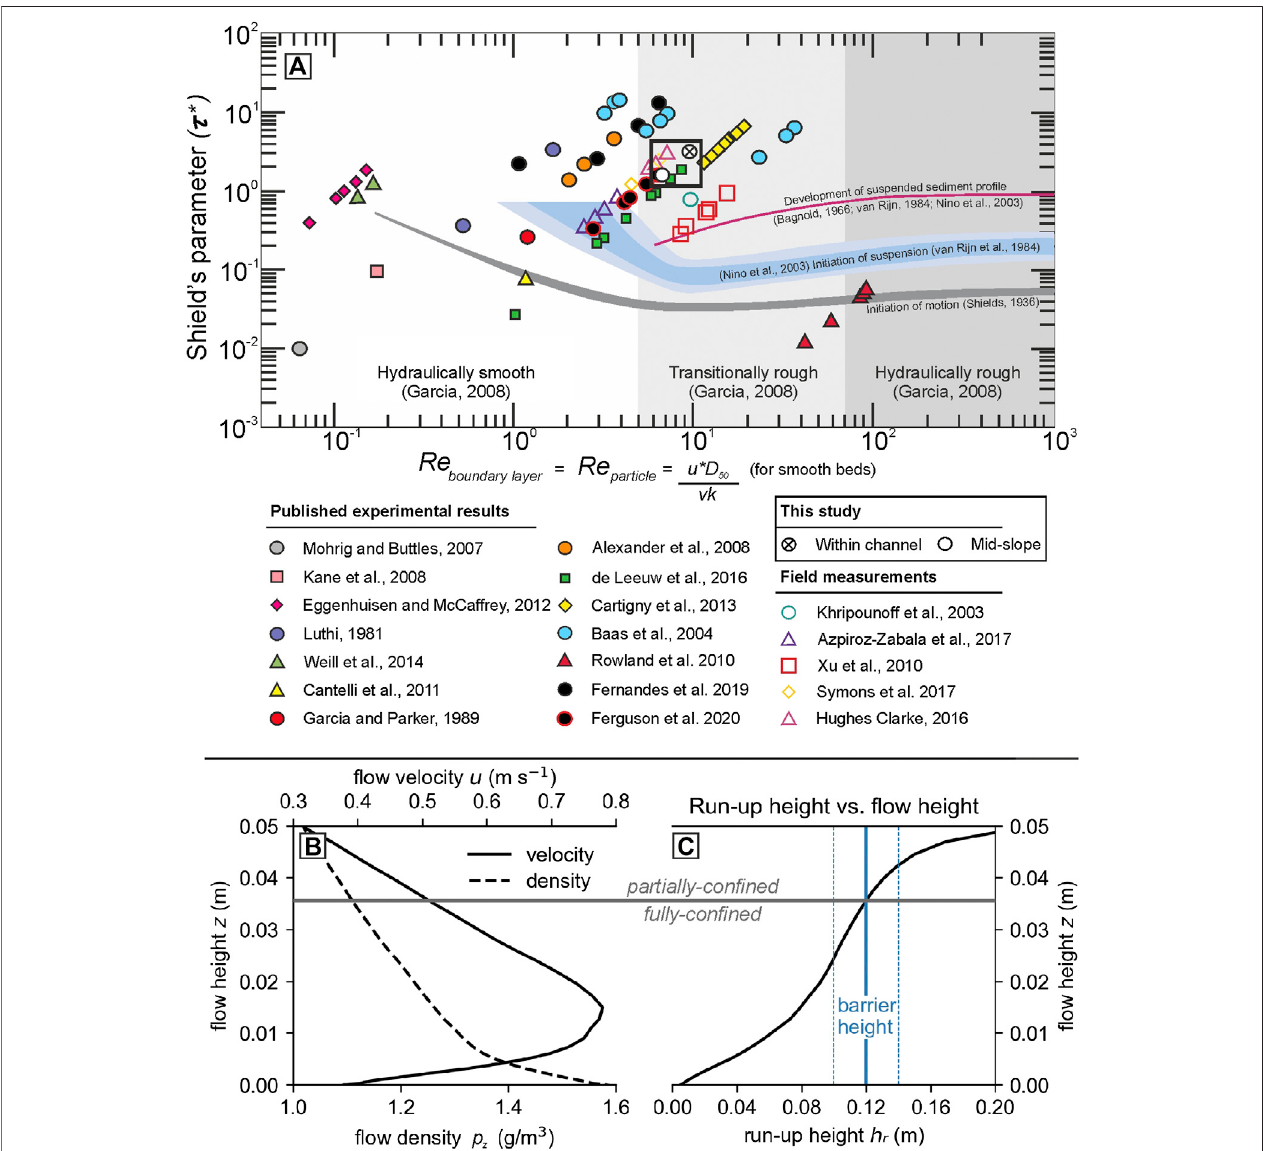
FIGURE2| (A) Shields-scaled experimentaland fi eld-measured fl ows(modi fi ed from de Leeuw et al., 2016;Fernandes et al.,2020).The fl ows produced by these experimentsareShields-scaledwithinthechannel(UVP1)andontheslope(UVP4)topromotebothsedimententrainmentandtransport,makingtheexperimental fl ows similar to natural fl ows. (B) Velocity (UVP 4) and density (predicted) pro fi les used for run-up height estimation. (C) The lower, denser part of the fl ow is con fi ned by the barrier, while the upper, less-dense part of the fl ow is able to run-up and surmount the barrier (C)